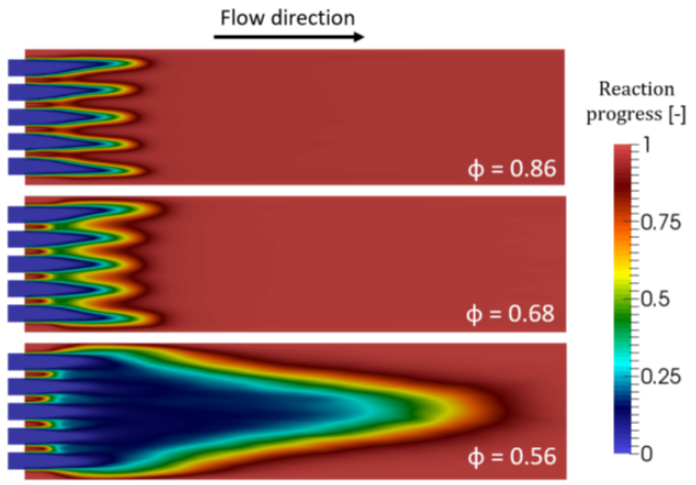
Figure 9. The simulation of flame shape elongation near LBO with the reduction of Φ at constant inlet velocity